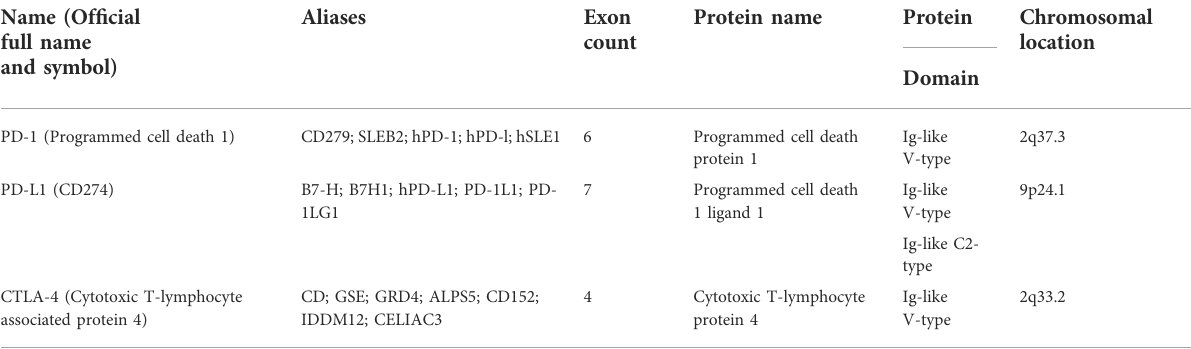
TABLE 1 Basic gene information and protein information of PD-1, PD-L1, CTLA-4. Name (Of fi